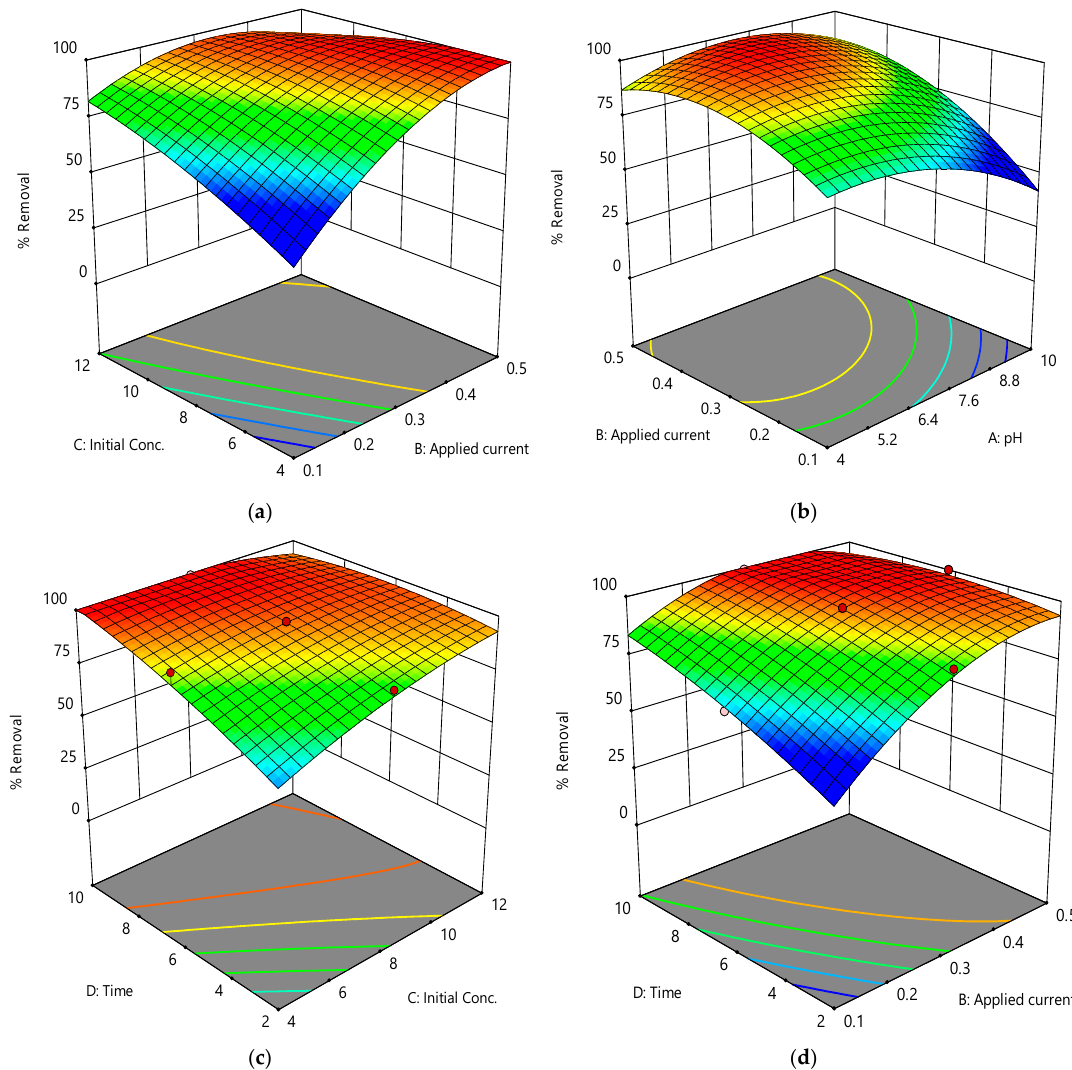
Figure 3. Surface plots (a–d) in 3D presenting the effect of all 4 interactive factors i.e., applied current, pH, time and initial conc. on the removal efficiency of total As.